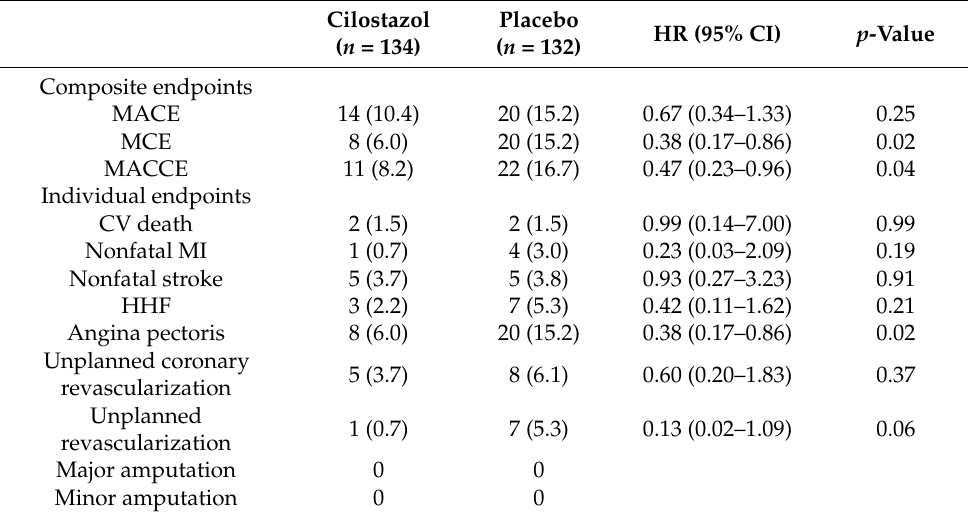
Table 2. Comparisons of the composite endpoints and individual endpoints between participants assigned to cilostazol and placebo (intention-to-treat